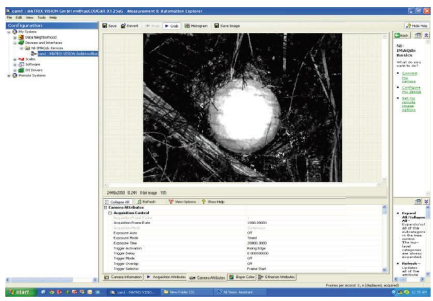
Figure 5: Image processing in LabVIEW. Table 3: S/N ratio for peel up and push down